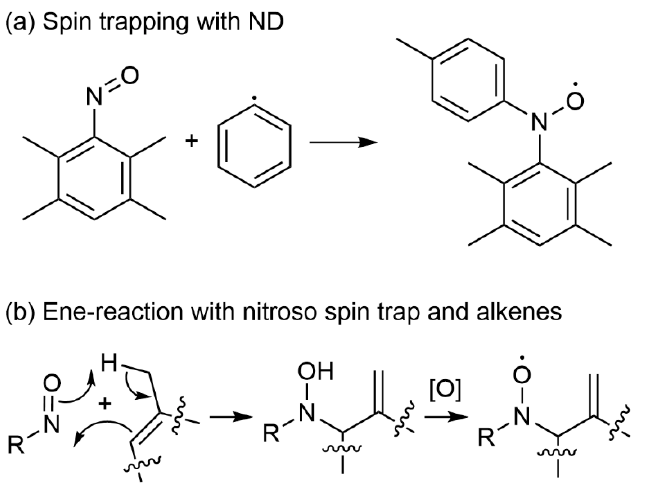
Figure 4. Typical reactions of nitroso spin traps: ( a ) spin trapping reaction of 4-methylphenyl radical by ND; ( b ) undesired ene-reaction with an alkene; the hydroxylamine formed in the pericyclic reaction is rapidly converted to a nitroxide in the presence of oxygen or another oxidant.